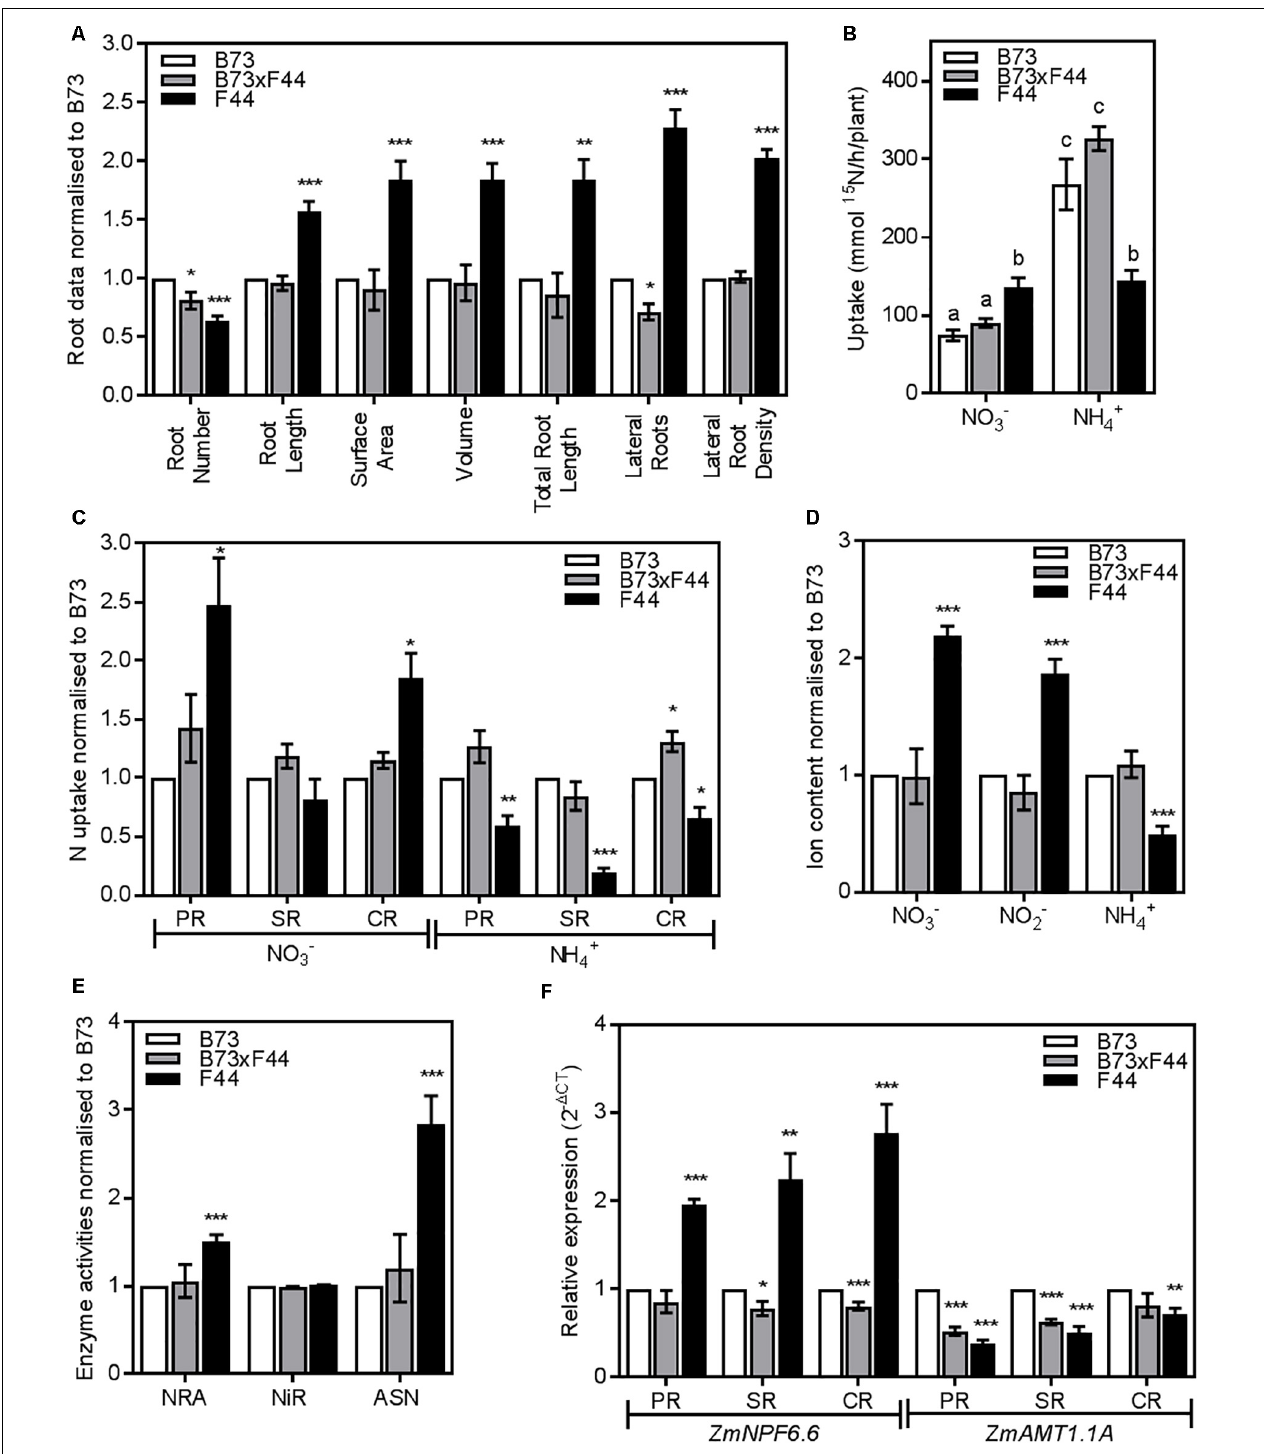
FIGURE 8 | Phenotypic comparison of F1 BK3 (gray) and parental B73 (white) and F44 (black) roots. (A) Crown root measurements normalized to B73. (B) Low affinity transport (LATS+HATS) of 2.5 mM of nitrate (NO 3 − ) and ammonium (NH 4 + ). (C) NO 3 − and NH 4 + LATS+HATS capacities in the PR, SR, and CR root tissues normalized to B73. (D) Measurements of nitrate (NO 3 − ), nitrite (NO 2 − ), and ammonium content (NH 4 + ) normalized to B73. (E) Analysis of nitrate reductase activity (NRA), nitrite reductase activity (NiR), and asparagine synthetase activity (ASN) normalized to B73. (F) ZmNPF6.6 and ZmAMT1.1A gene expression in the PR, SR, and CR root tissues normalized to B73. Values are means ( ± SE) from 3 to 8 individual plants. Asterisks indicate significant differences with B73 at ∗ P < 0.05, ∗∗ P < 0.01, ∗∗∗ P < 0.005 (Student’s t -test). Different letters indicate significant differences among means at P < 0.05 (ANOVA).